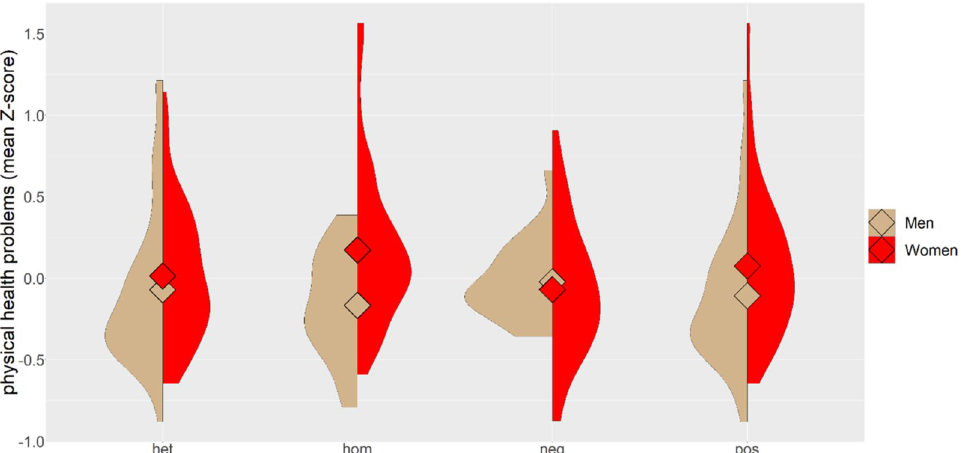
Figure 1. Physical health problems score of men and women with different RHD genotype. The figure shows the means and the distribution computed as the kernel probability density for male and female heterozygotes (het), RhD-positive homozygotes (hom), RhD-negative homozygotes (neg), and RhD positive participants